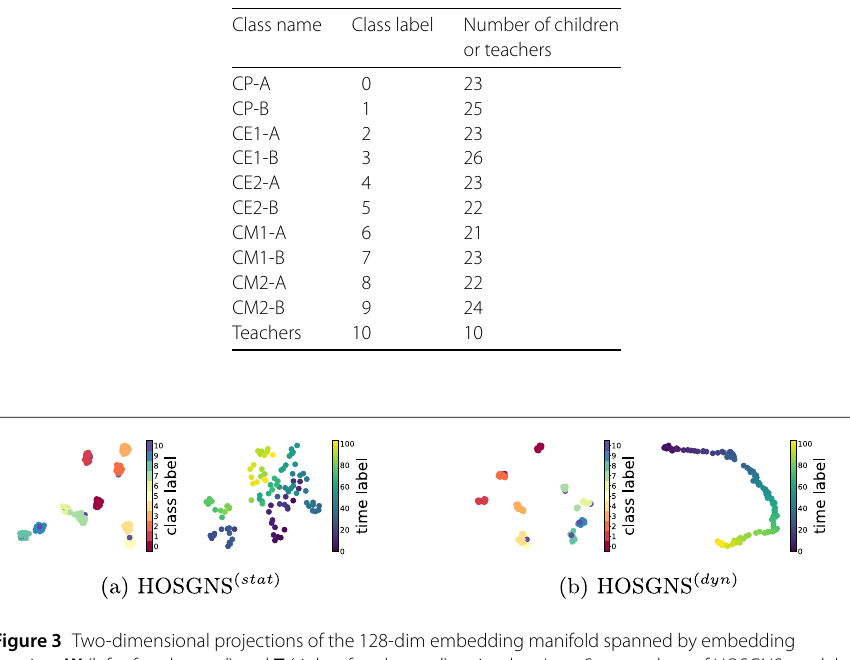
Table 8 Number of class components for each labelled class in L YON S CHOOL dataset